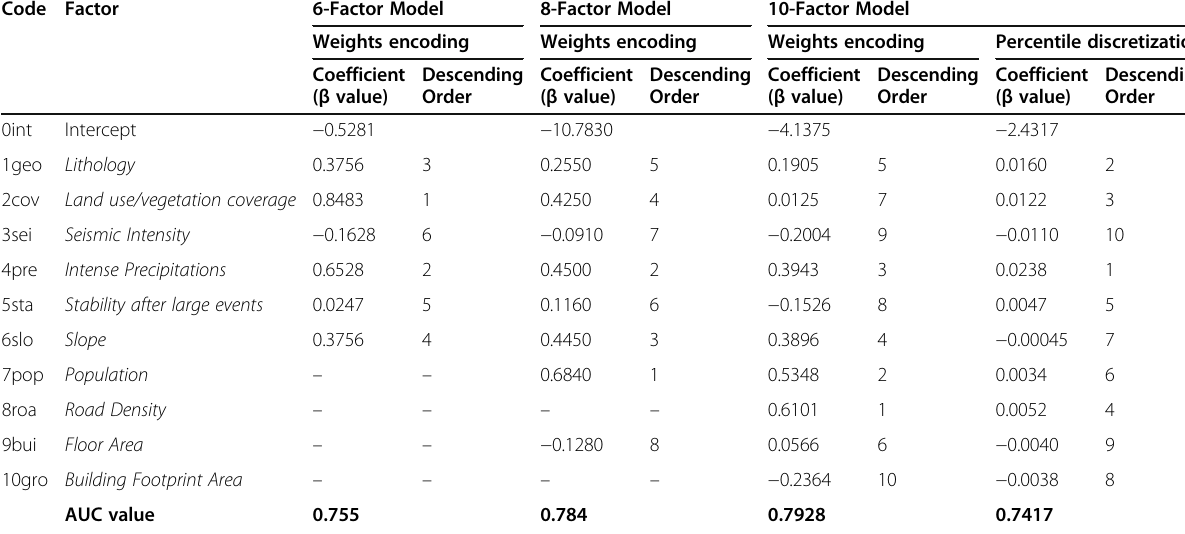
Table 6 Output values from LOGIT modelling for landslide susceptibility in Quito Code